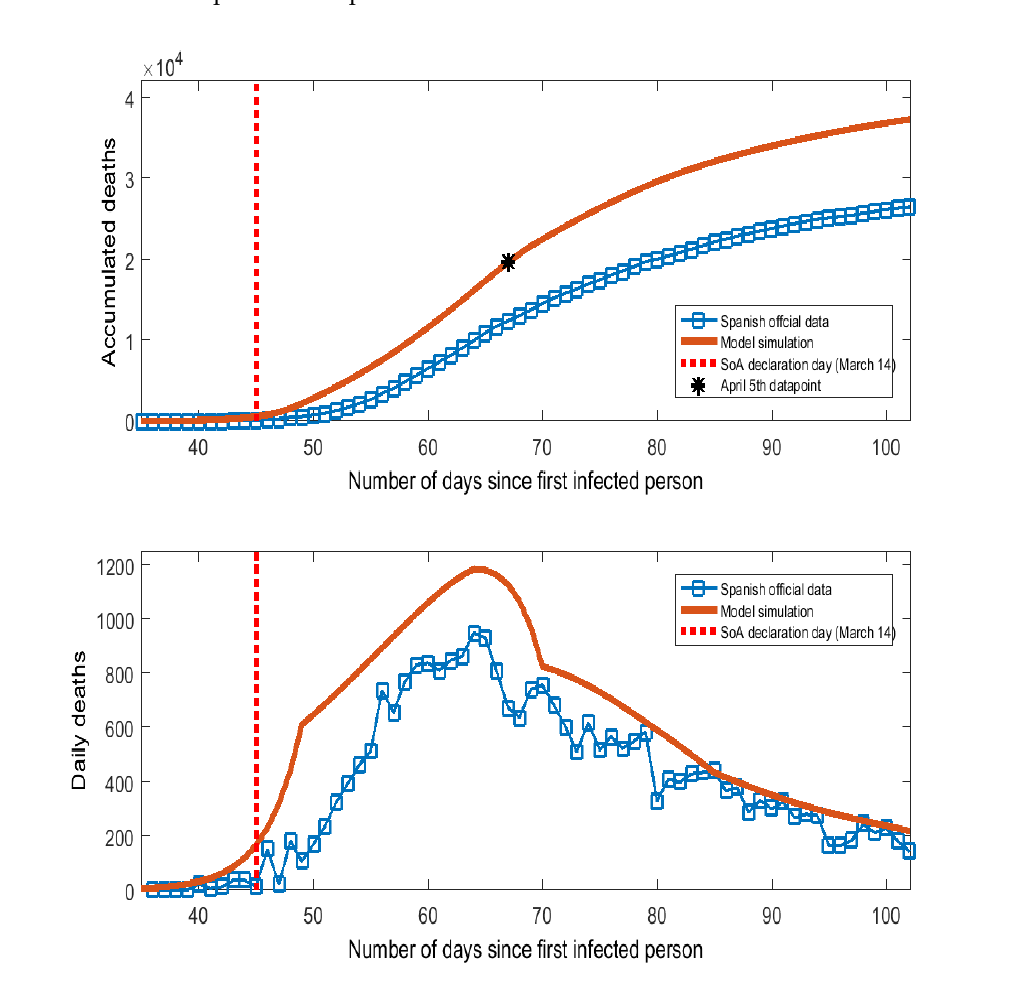
Figure 1. Deaths caused by COVID-19 in